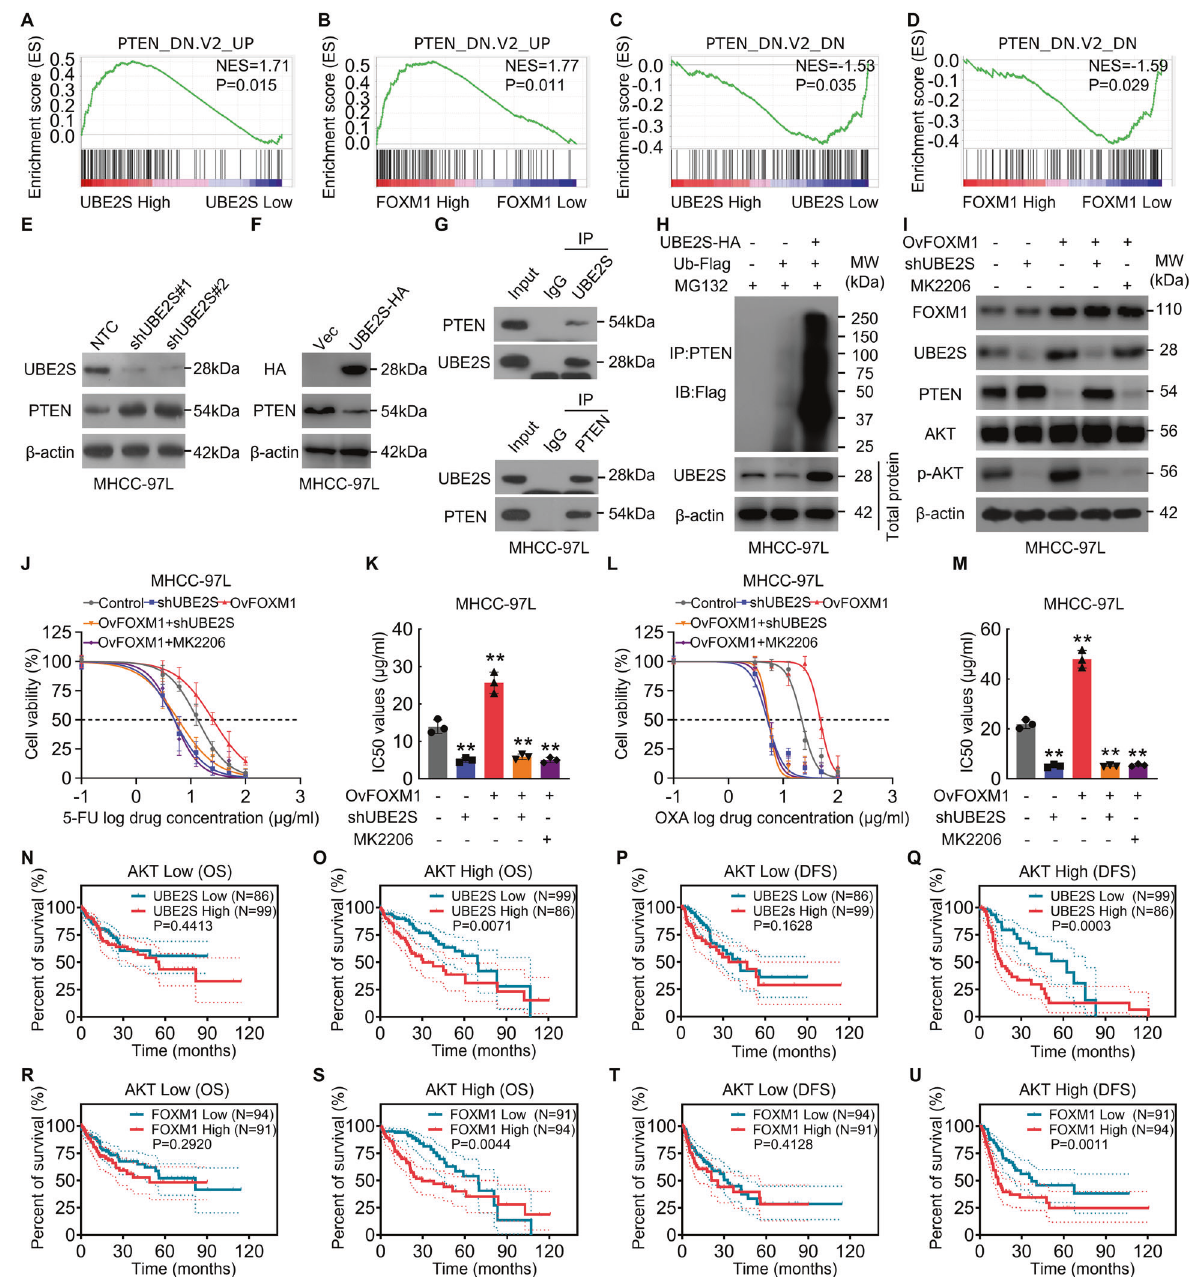
Fig. 5 UBE2S promotes the ubiquitination of PTEN, enhancing HCC cell chemoresistance by activating AKT pathway. A , B GSEA plots show the enrichment of gene upregulated in cancer cells upon the knockdown of PTEN between the HCC tissues with UBE2S high and UBE2S low ( A ), or between the HCC tissues with FOXM1 high and FOXM1 low ( B ). C , D GSEA plots show the enrichment of gene downregulated in PTEN-knockdown cancer cells between the HCC tissues with UBE2S high and UBE2S low ( C ), or between the HCC tissues with FOXM1 high and FOXM1 low ( D ). E , F PTEN protein levels were investigated in UBE2S-knockdown ( E ) or UBE2S-overexpression ( F ) MHCC-97L cells. G UBE2S (Upper) and PTEN (Lower) complexes were co-immunoprecipitated with UBE2S and PTEN antibodies and immunoblotted with the indicated antibodies. H MHCC-97L cells overexpressed indicated proteins were treated with MG132 (10 μ M) for 8 h, and the ubiquitination levels of PTEN protein were investigated. I – M MHCC-97L cells infected with indicated lentiviral plasmids and treated with MK2206 (5 μ M) or DMSO (control) for 8 h. The indicated protein levels ( I ) and cytotoxic effects upon 5-FU ( J , K ) and oxaliplatin ( L , M ) were investigated. N , O The OS curves based on UBE2S transcript levels between HCC subgroup of AKT low ( N ) or high ( O ) expression. P , Q The DFS curves based on UBE2S transcript levels between HCC subgroup of AKT low ( P ) or high ( Q ) expression. R , S The OS curves based on FOXM1 transcript levels between HCC subgroup of AKT low ( N ) or high ( O ) expression. T , U The DFS curves based on FOXM1 transcript levels in HCC subgroup of AKT low ( T ) or high ( U ) expression.